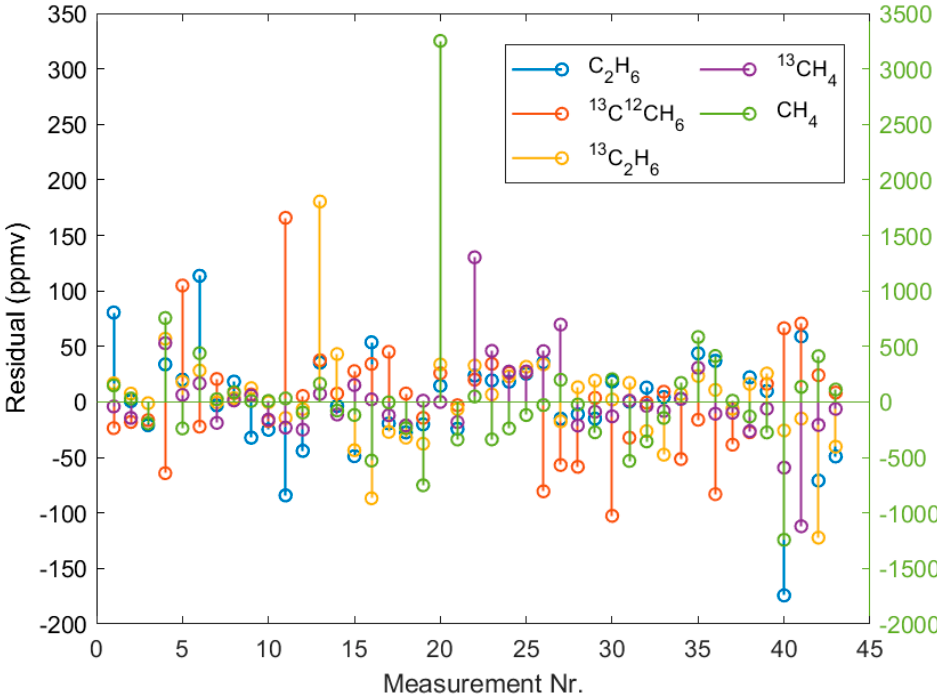
Figure A3. Cross validation residual of the ICL 1541 measurements. The y-axis on the right side refers to CH 4 (green).